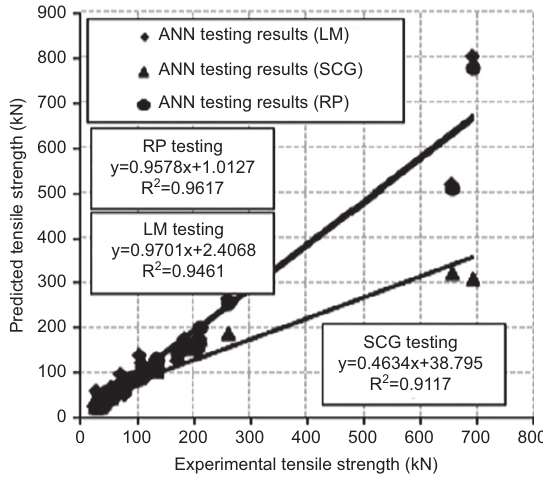
Figure 7 ANN (SCG, LM, and RP algorithms) results for group anchors.